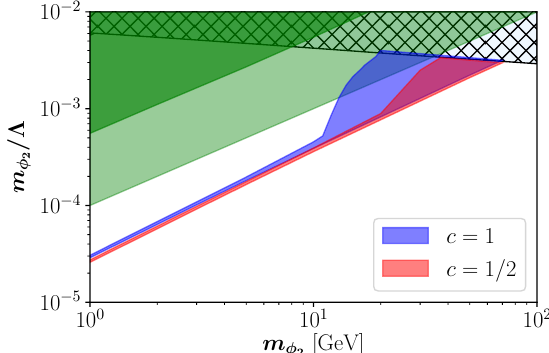
Figure 11 . Regions of the ( m (cid:30) ; (cid:3)) plane characterized by the fact that the measured baryon 2 asymmetry of the Universe and the DM relic abundance can be reproduced simultaneously, for c = 1 (blue region) and c = 1 = 2 (red region). The upper hatched region corresponds to the bound in eq. (6.3) together with eq. (6.4), such that our consideration of an asymmetric (cid:30) 2 giving rise to an asymmetric DM X remains valid. The light green region is excluded by di-jet bound in the simplest model. The dark green region is excluded by mono-photon measurements at LEP in the next-to-simplest